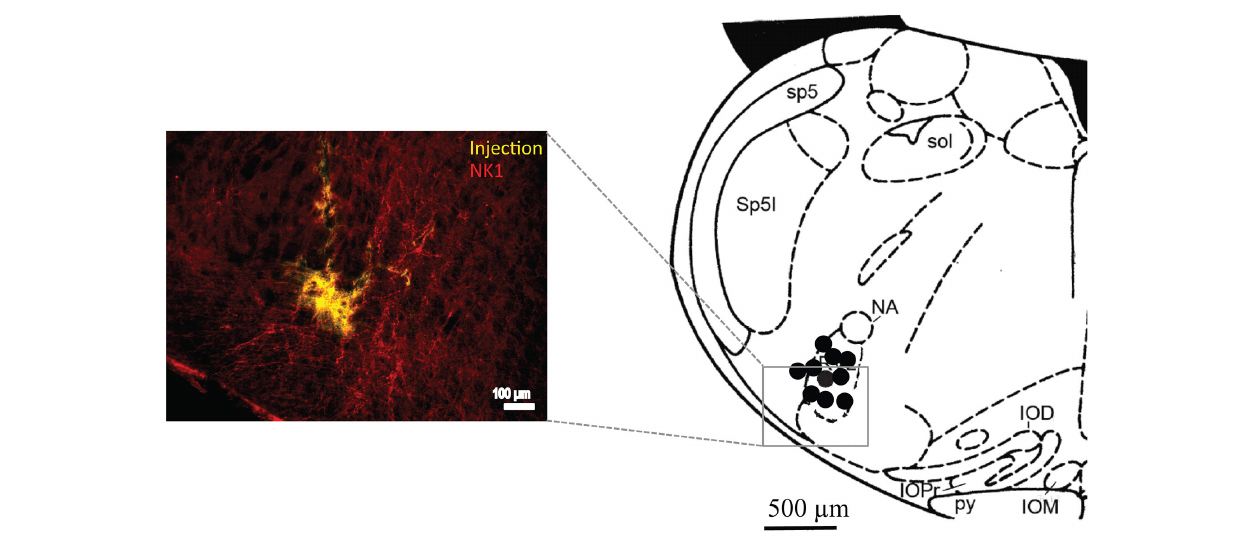
FIGURE 6 | Immunohistochemical analysis of brainstem tissue sections confirm injection sites within the preBötC. Left side, a fluorescent image showing an injection site in the preBötC surrounded by red NK1 receptor immunofluorescence. The right side shows a schematic of a coronal section of the brainstem at the level of the preBötC showing sites of the AOAA microinjections (black dots). sol, solitary tract; sp5, spinal trigeminal tract; Sp5l, spinal trigeminal nucleus, interpolar part; NA, nucleus ambiguus; IOD, inferior olive, dorsal nucleus; IOM, inferior olive, medial nucleus; IOPr, inferior olive, principal nucleus; py, pyramidal